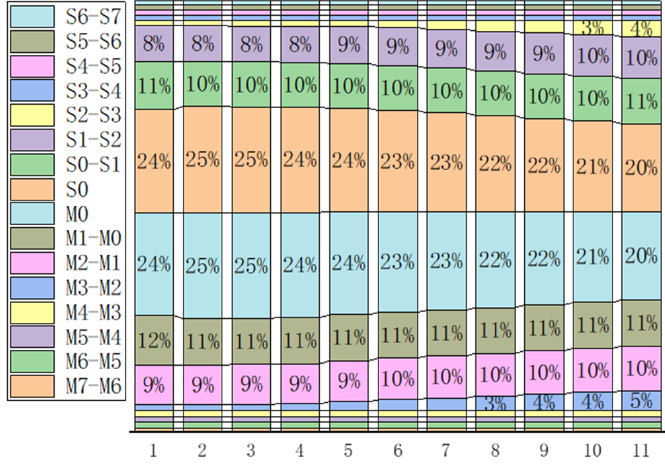
Figure 15. Energy distribution at each interface with the change in the platform force.